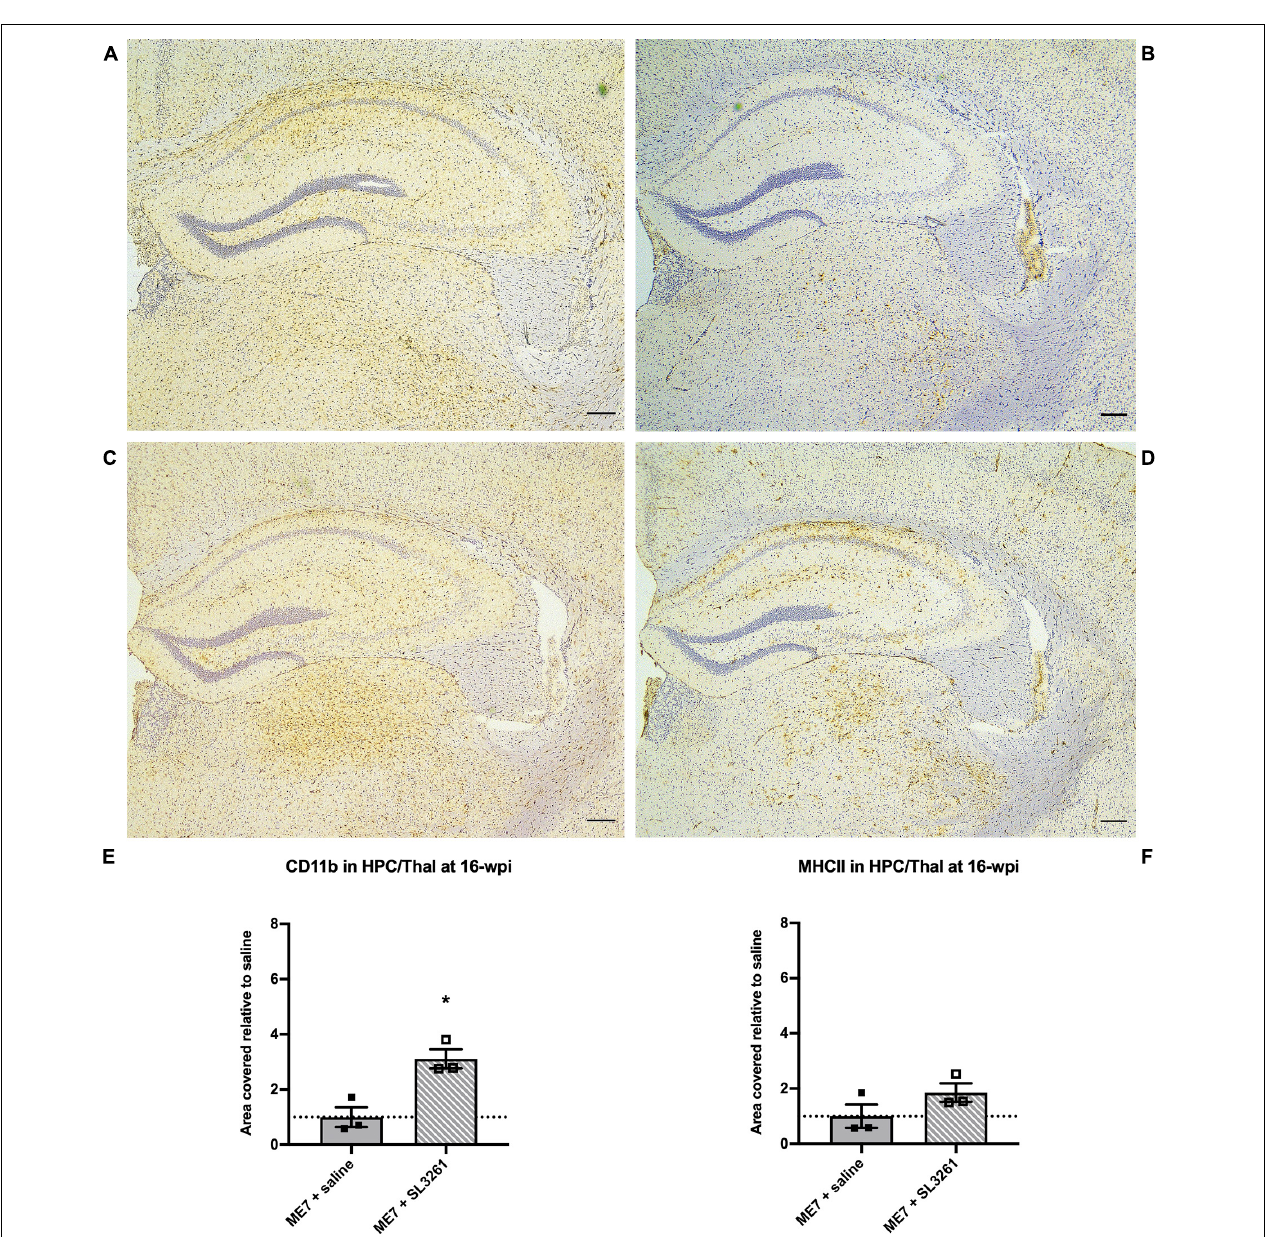
FIGURE 2 | Neuroinflammatory response at mid-stage ME7 prion disease. Neuroinflammatory response in the hippocampus and thalamus of ME7 prion mice 4 weeks after systemic injection of saline or 1 × 10 6 cfu S. typhimurium SL3261 at 12-wpi. Representative images showing CD11b (A,C) and MHCII (B,D) expression. Scale bar = 200 microns. Quantification of staining shows increased expression after systemic infection with S. typhimurium compared to saline injection for CD11b (E) but not MHCII (F) . * p < 0.05 vs. ME7 + saline using one-tailed Mann-Whitney U -test; n = 3/group.